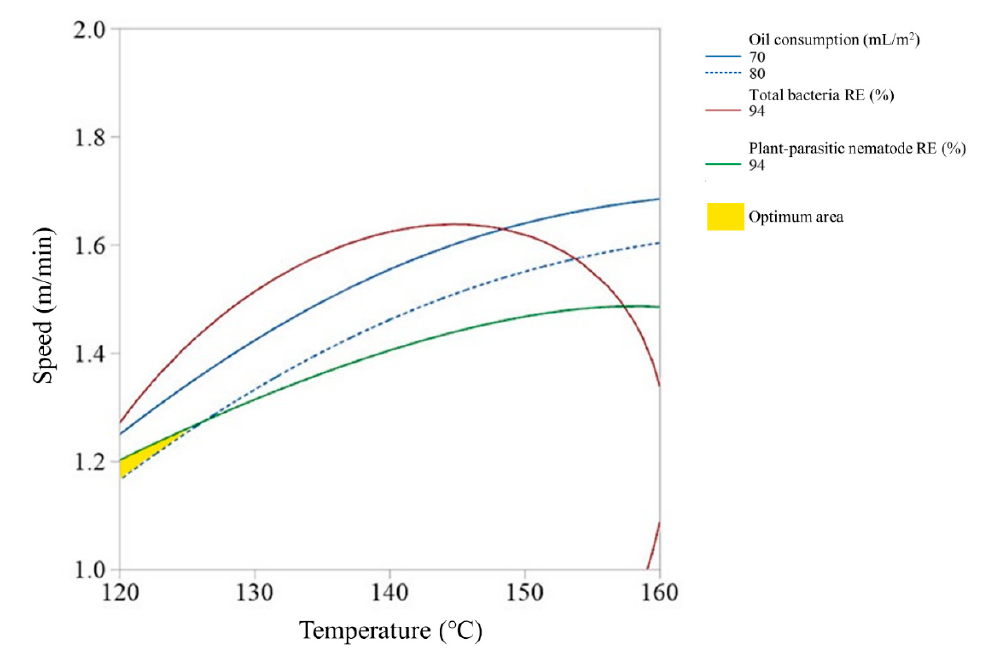
Figure 6. Overlay plot of the steam temperature and running speed on the response variables when the spray depth is 12 cm.